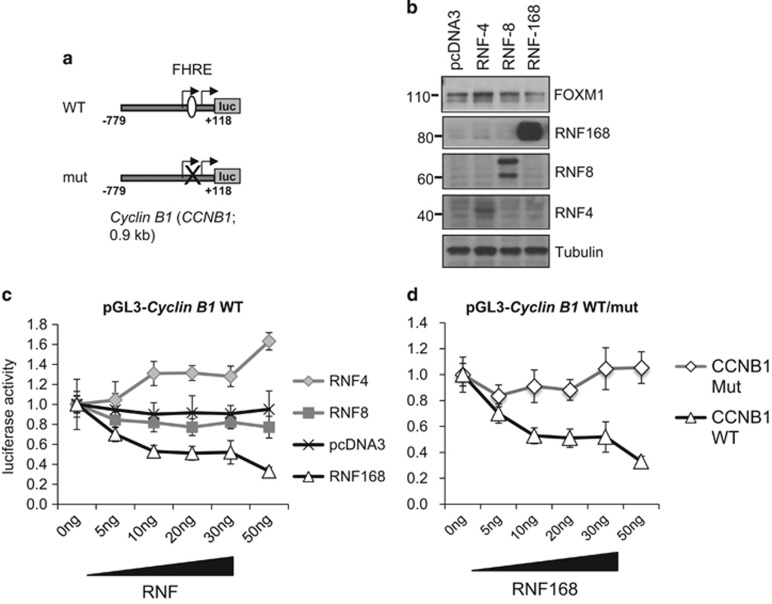
Overexpression of RNF168, but not RNF4 and RNF8, effectively repressed FOXM1 transcriptional activity. (a) Schematic showing of the WT (pGL2-Cyclin B1-WT) and the FOXM1-mutant (pGL2-Cyclin B1-mut) Cyclin B1 promoter/reporter. (b) MCF-7 cells were co-transfected with the WT cyclin B1 promoter (pGL2-Cyclin B1-WT) and 20 ng of the empty expression vector (pcDNA3), Flag-RNF4, HA-RNF8 or Flag-RNF168 expression vector. Forty-eight hours after transfection, the transfected cells were western blotted for the expression of FOXM1, RNF168, RBF8, RNF4 and β-tubulin. (c) MCF-7 cells were co-transfected with the luciferase reporter driven by the WT cyclin B1 promoter (pGL2-Cyclin B1-WT) and the empty expression vector (pcDNA3) or the Flag-RNF4, HA-RNF8 or Flag-RNF168 expression vector (0–50 ng) for 48 h as in (b). Reporter gene activity was expressed as a ratio of firefly luciferase activity to control Renilla luciferase activity. The promoter activity assay results are presented as bars representing mean±s.d. of three independent experiments in triplicates. All DNA concentrations were normalized using empty vector. (d) MCF-7 cells were co-transfected with Flag-RNF168 expression vector (0, 5, 10, 20, 30 and 50 ng) and the luciferase reporter driven by the WT cyclin B1 promoter (pGL2-Cyclin B1-WT) or the mutant cyclin B1 promoter (pGL2-Cyclin B1-mut) and the Flag-RNF168 expression vector (0–50 ng) for 48 h. Reporter gene activity was expressed as a ratio of firefly luciferase activity to control Renilla luciferase activity. The promoter activity assay results are presented as bars representing mean±s.d. of three independent experiments in triplicates. **P⩽0.01, ***P⩽0.001 and ns indicates no significance by Student's t-test.